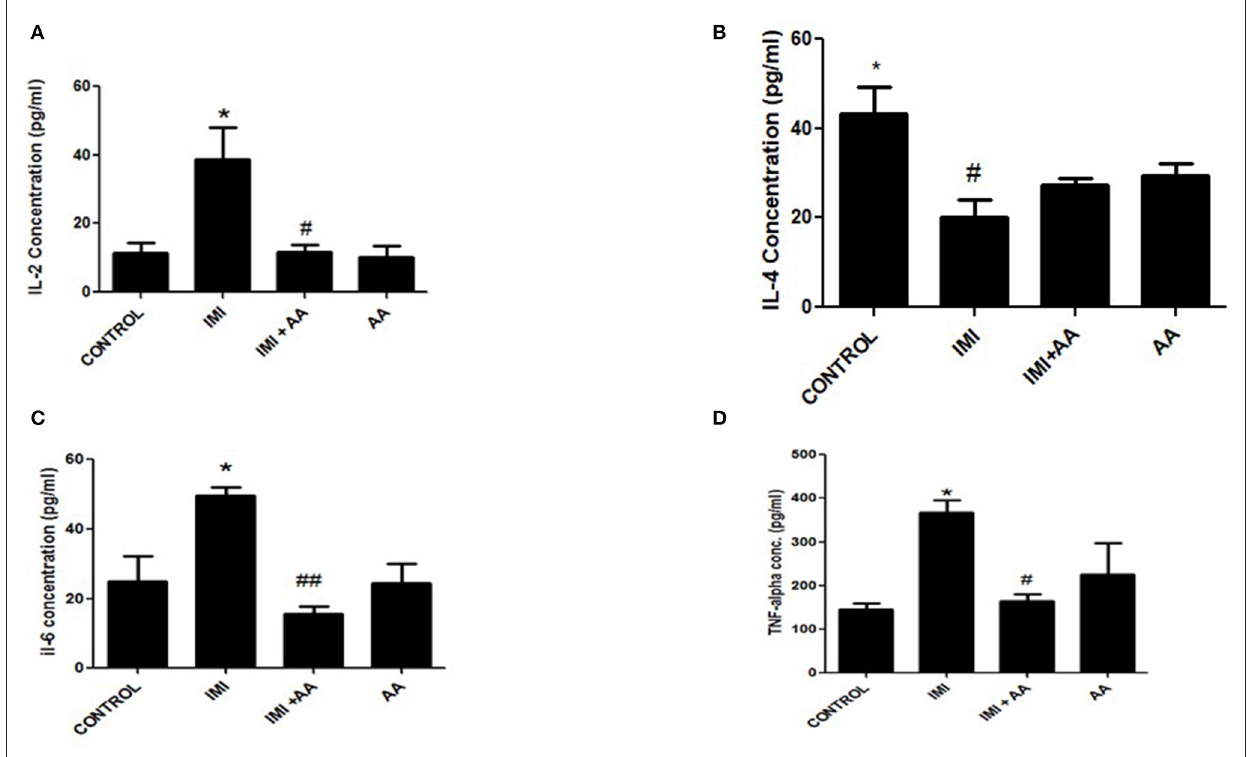
FIGURE5 The effect of Ascorbic acid on inflammatory biomarkers. Column figure shows the inflammatory biomarkers measured in whole brain homogenates of control, IMI, IMI + Ascorbic acid, and Ascorbic acid treated animals. (A) Interleukins-2; (B) Interleukins-4; (C) Interleukins-6; (D) TNF- alfa. Data represent mean ± SEM. n = 6 for each group. * Represents significant values when compared to controls at P < 0.05, # Represents significant values when compared to IMI-treated animals at P < 0.05. ## P ≤ 0.01. These data represent the significant different between treatment and disease control